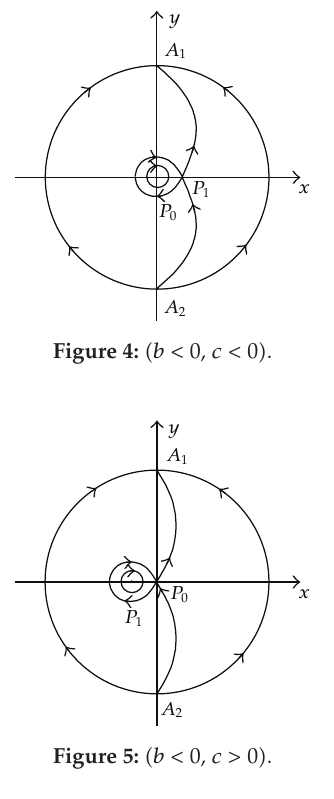
Figure 5: (cid:6) b < 0, c > 0 (cid:7)